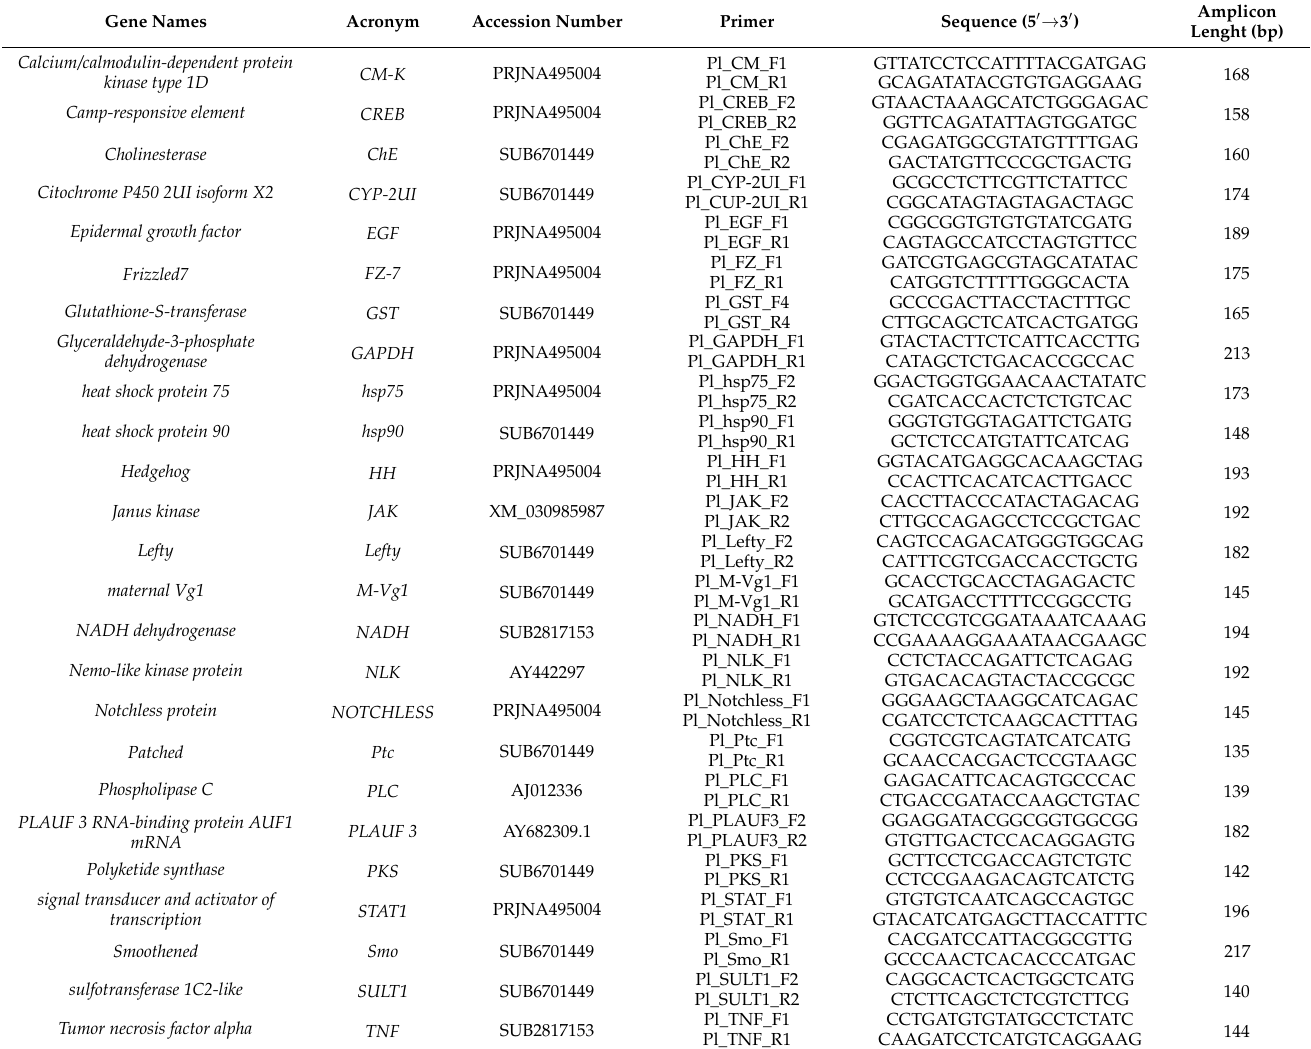
Table 1. Gene Name, Acronym, Accession Numbers, Primer Names, Primer Sequences and Amplicon Lengths of PCR Frag-